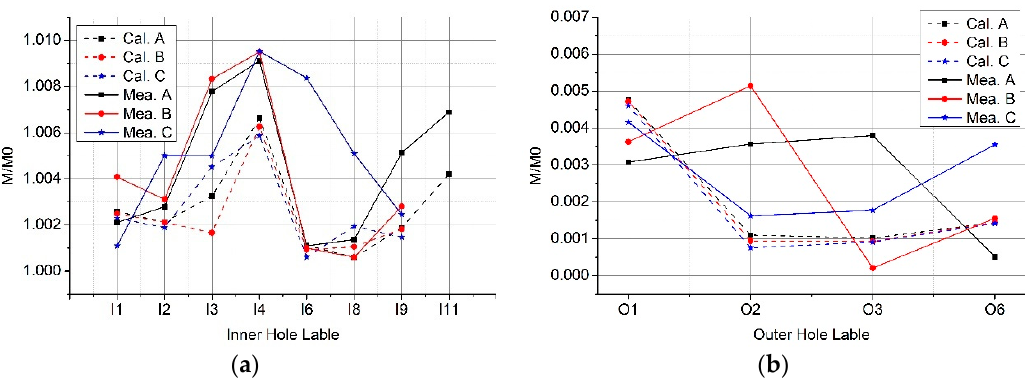
Figure 13. Normalized mutual inductance between the Rogowski coils and the D-shaped primary conductors. ( a ) The D-shaped conductor through the inner holds; ( b ) the D-shaped conductor through the outer side holds.